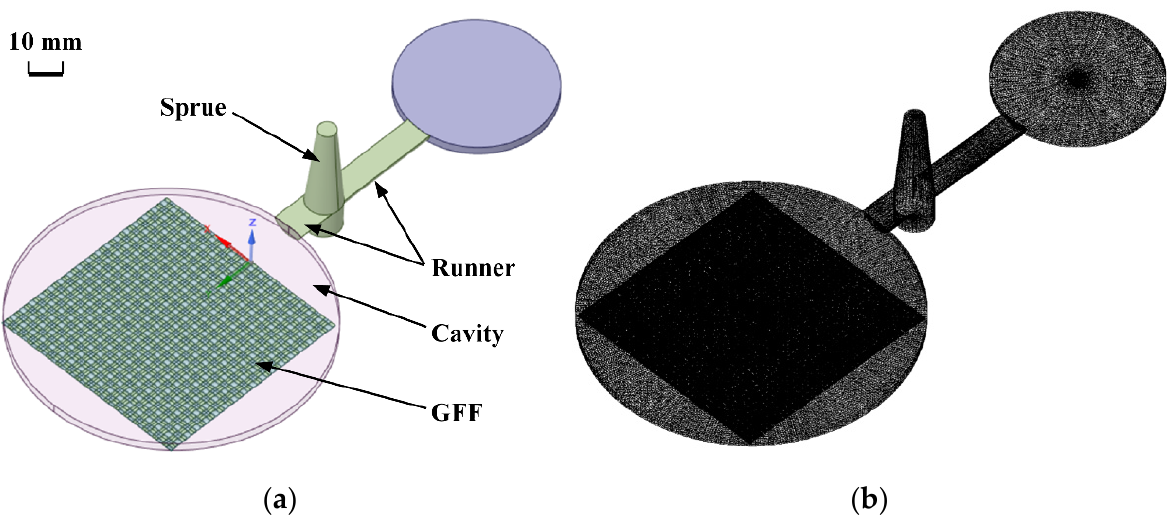
Figure 2. 3D model of the insert injection molding with GFF EWR300 ( a ), and the mech model ( b ).